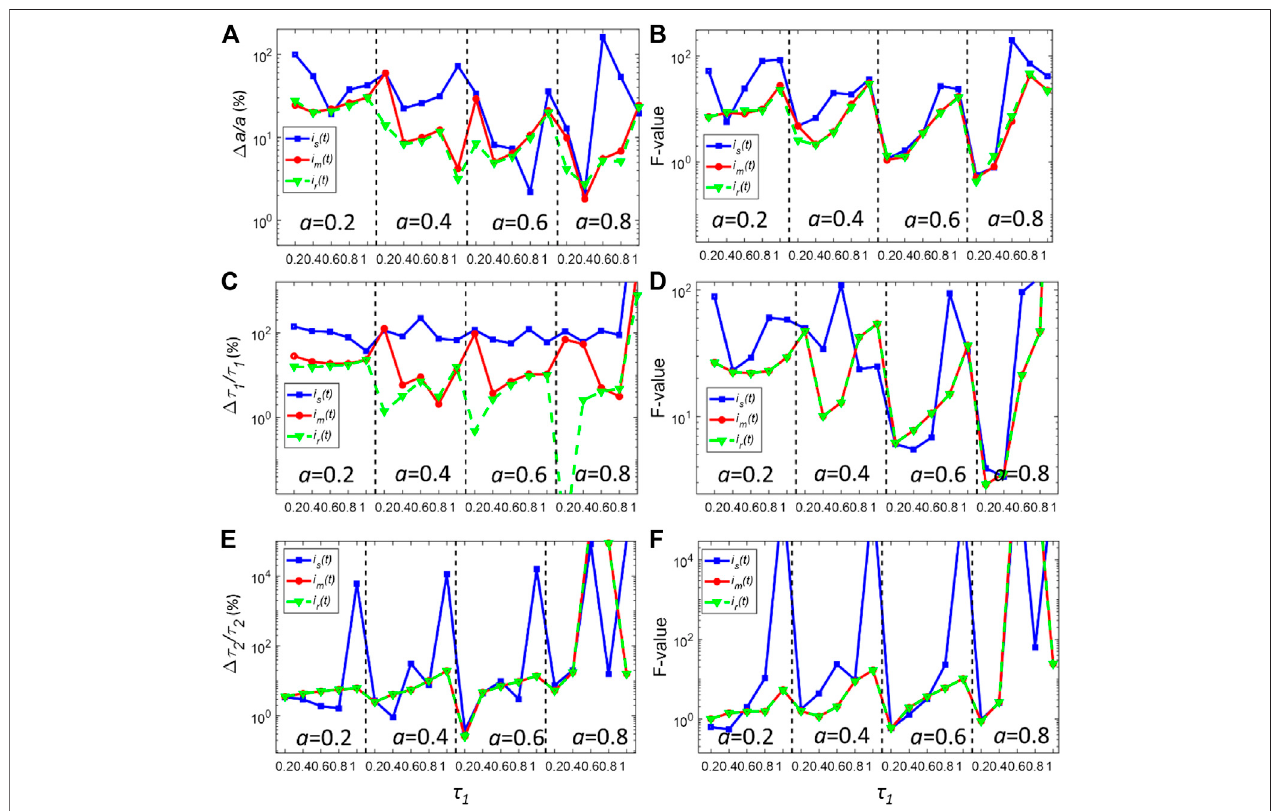
FIGURE 5 | (A,C,E) Normalized bias plots for a , τ 1 and τ 2 when N c (cid:2) 5000 using LSD-LE method with ( α , L ) (cid:2) (0.92,16). The corresponding F-value plots are depicted in (B,D,F) .